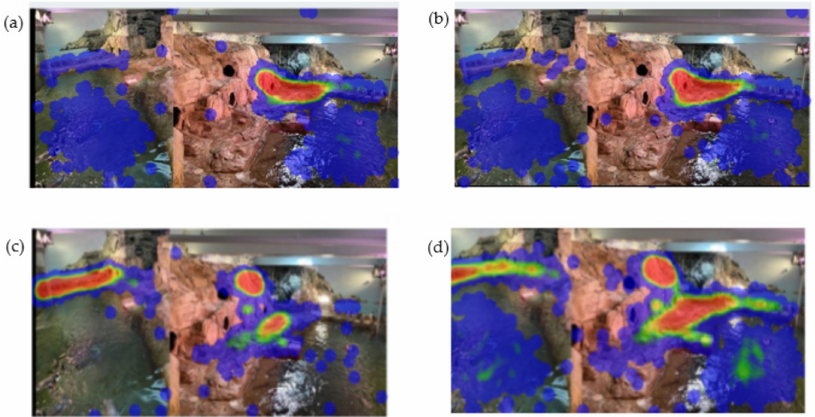
Figure 8. Heat maps generated by Zoo Monitor. Red indicates areas in which individuals spent the most time, and blue the least time. Upper panels: Yellow pair (female “Araya” ( a ) on the left, male “Lou” ( b ) on the right). Lower panels: Purple pair (Female “DJ” ( c ) on the left, male “Niño” ( d ) on the right), Heat maps for all remaining penguins are available in the supplemental material (Figures S1–S6).